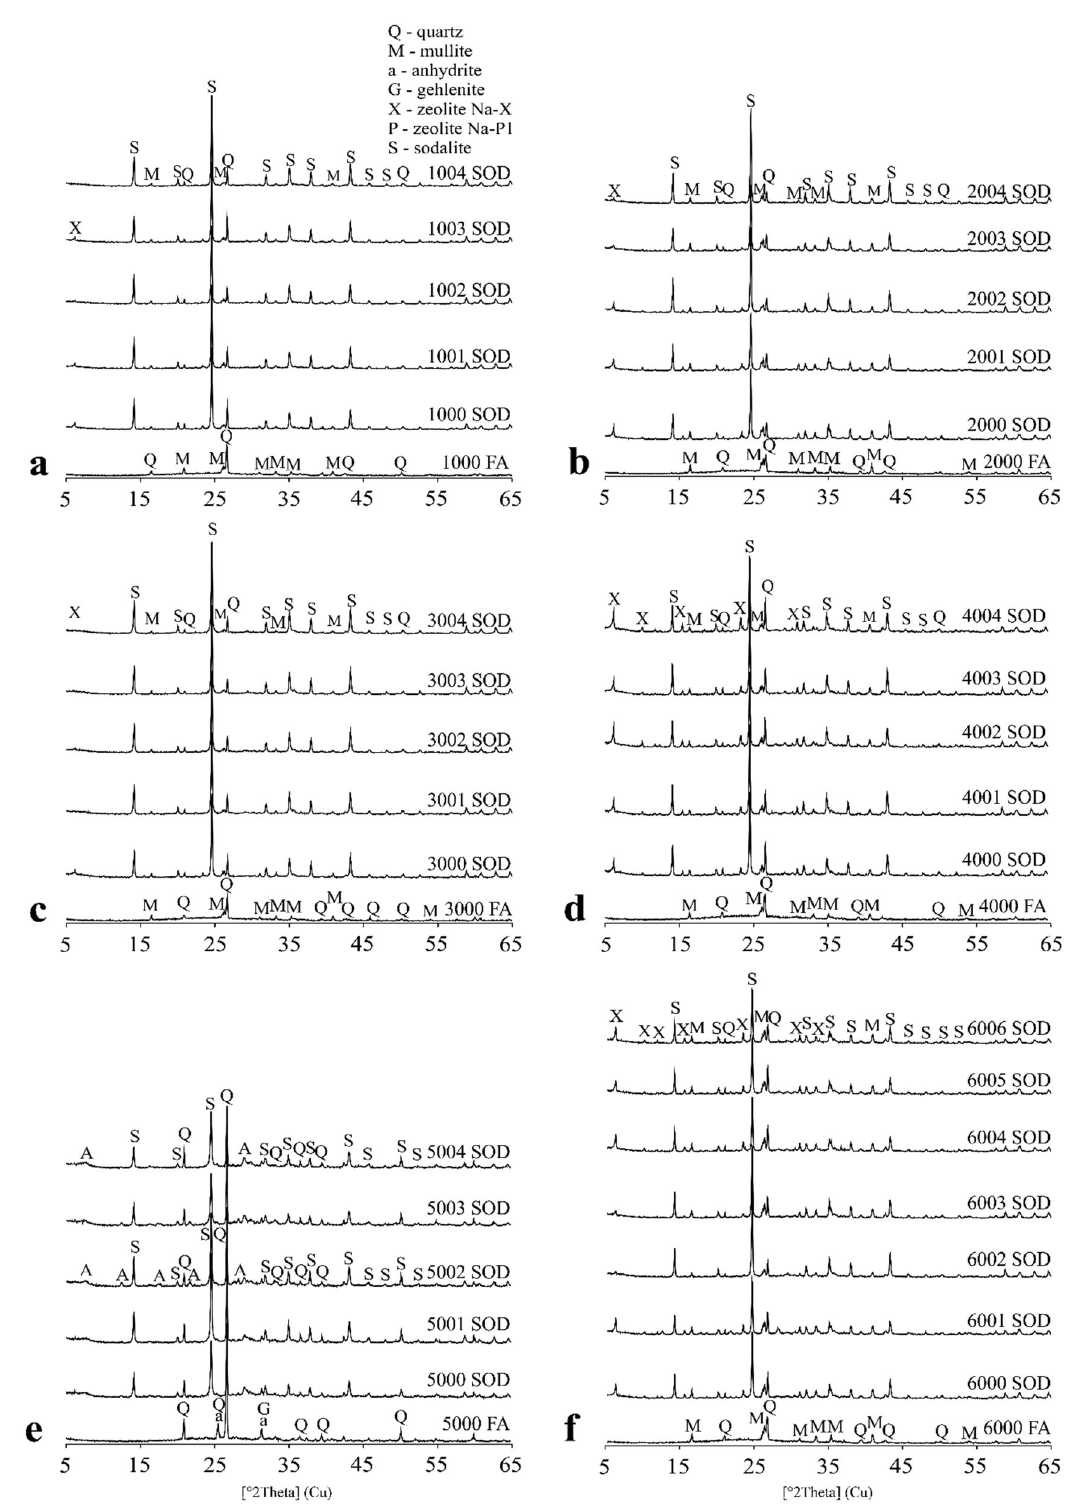
Fig. 6 XRD analyses of raw fly ashes and attempts of sodalite